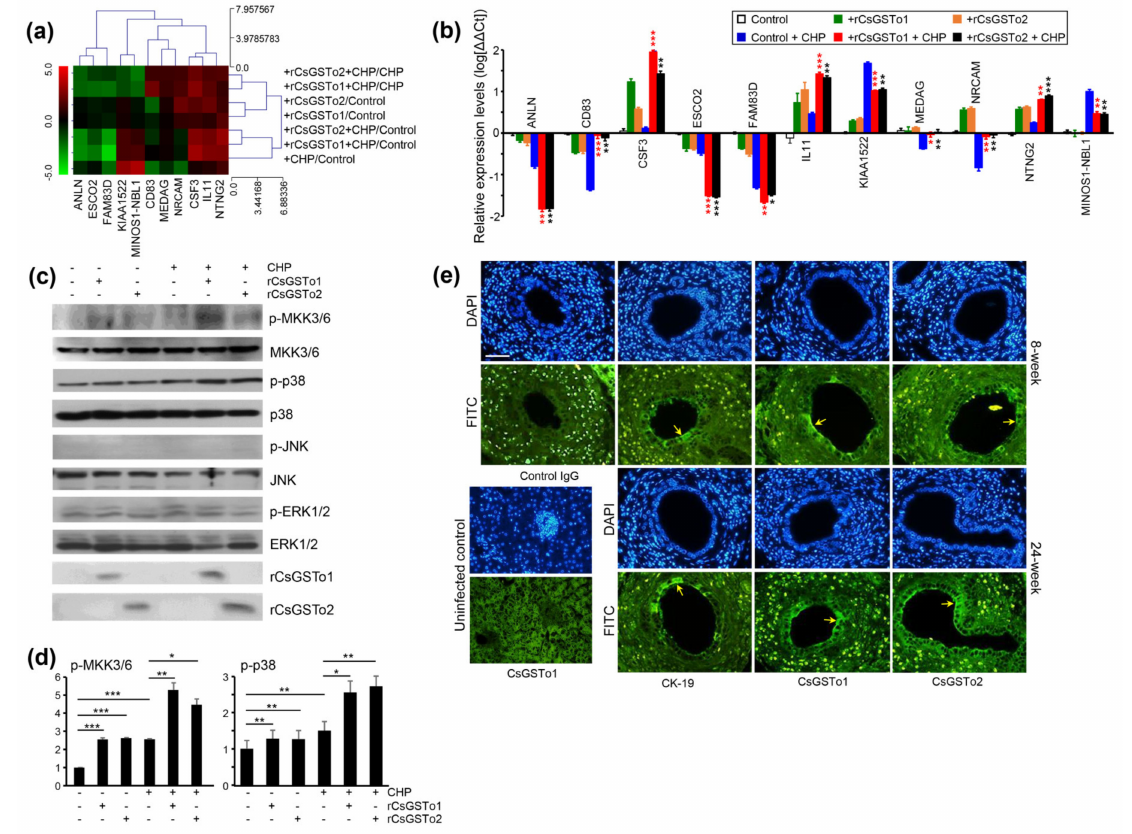
Figure 5. rCsGSTos regulated protein kinase activity as well as controlled transcriptional levels of genes associated with cell differentiation and are distributed in C. sinensis -infected rat biliary epithelium together with CK-19. ( a ) Expressional changes of gene cluster. RNAs isolated from each conditioned cell were subjected to Quant-RNAseq array. ( b ) qRT-PCR analysis of gene cluster shown in panel a. β -actin gene was used as the internal control for normalization. * p < 0.05, ** p < 0.01, *** p < 0.001. ( c ) Western blot analysis of phosphorylation of MKK3/6, p38, JNK and ERK1/2. ( d ) Increase in phosphorylated forms of protein kinases analyzed by relative fold intensity. The intensity of respective bands was quantified by ImageJ analysis (https://imagej.nih.gov/ij/, accessed on 11 November 2020). * p < 0.05, ** p < 0.01, *** p < 0.001. ( e ) Distribution of CsGSTos and CK-19 in C. sinensis -infected rat biliary ductal epithelium. Sections were probed with anti-CK-19, anti-rCsGSTo1 or 2 antibodies. Along with infection duration, CsGSTo accumulates were increased and the distribution pattern was consistent with CK-19 (arrows). Nuclear staining was carried out with DAPI. Anti-CK-19 and control IgG were used as cell differentiation marker and negative control, respectively. Liver specimens from uninfected rat was used to examine the absence of CsGSTo proteins. Immunostaining using anti-rCsGSTo1 is shown. Eight- and 24-week each denotes post-infection weeks. Bar = 10 µ